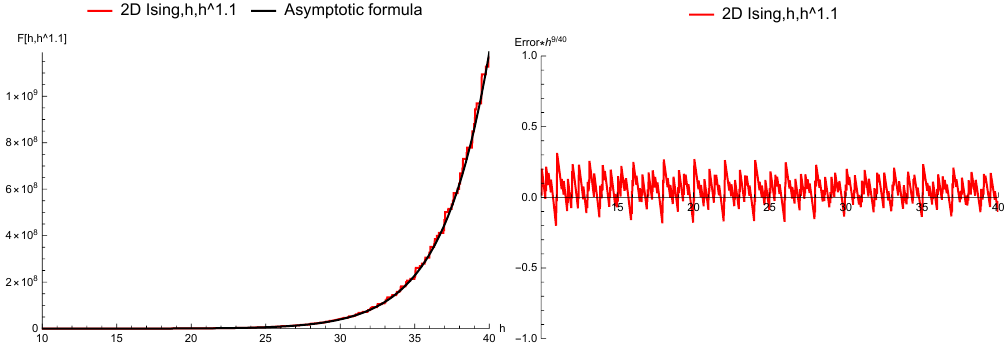
Figure 13 . In the left (cid:12)gure, the black curve is the asymptotic Cardy formula while the red curve is the actual number of operators till ( h; (cid:22) h ) present in the Ising model. Here we have taken h = (cid:22) h (cid:0) 1. The picture on the right hand side plot the relative error times h 1 = 4 . The error times h 1 = 4 is bounded above and below by an order one number. 2D Ising,h,h^1.1